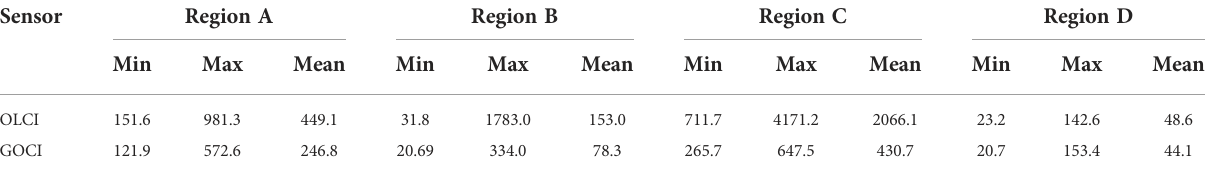
TABLE 4 Statistics of SSC in the experimental regions based on 2017 data (unit: mg/L).